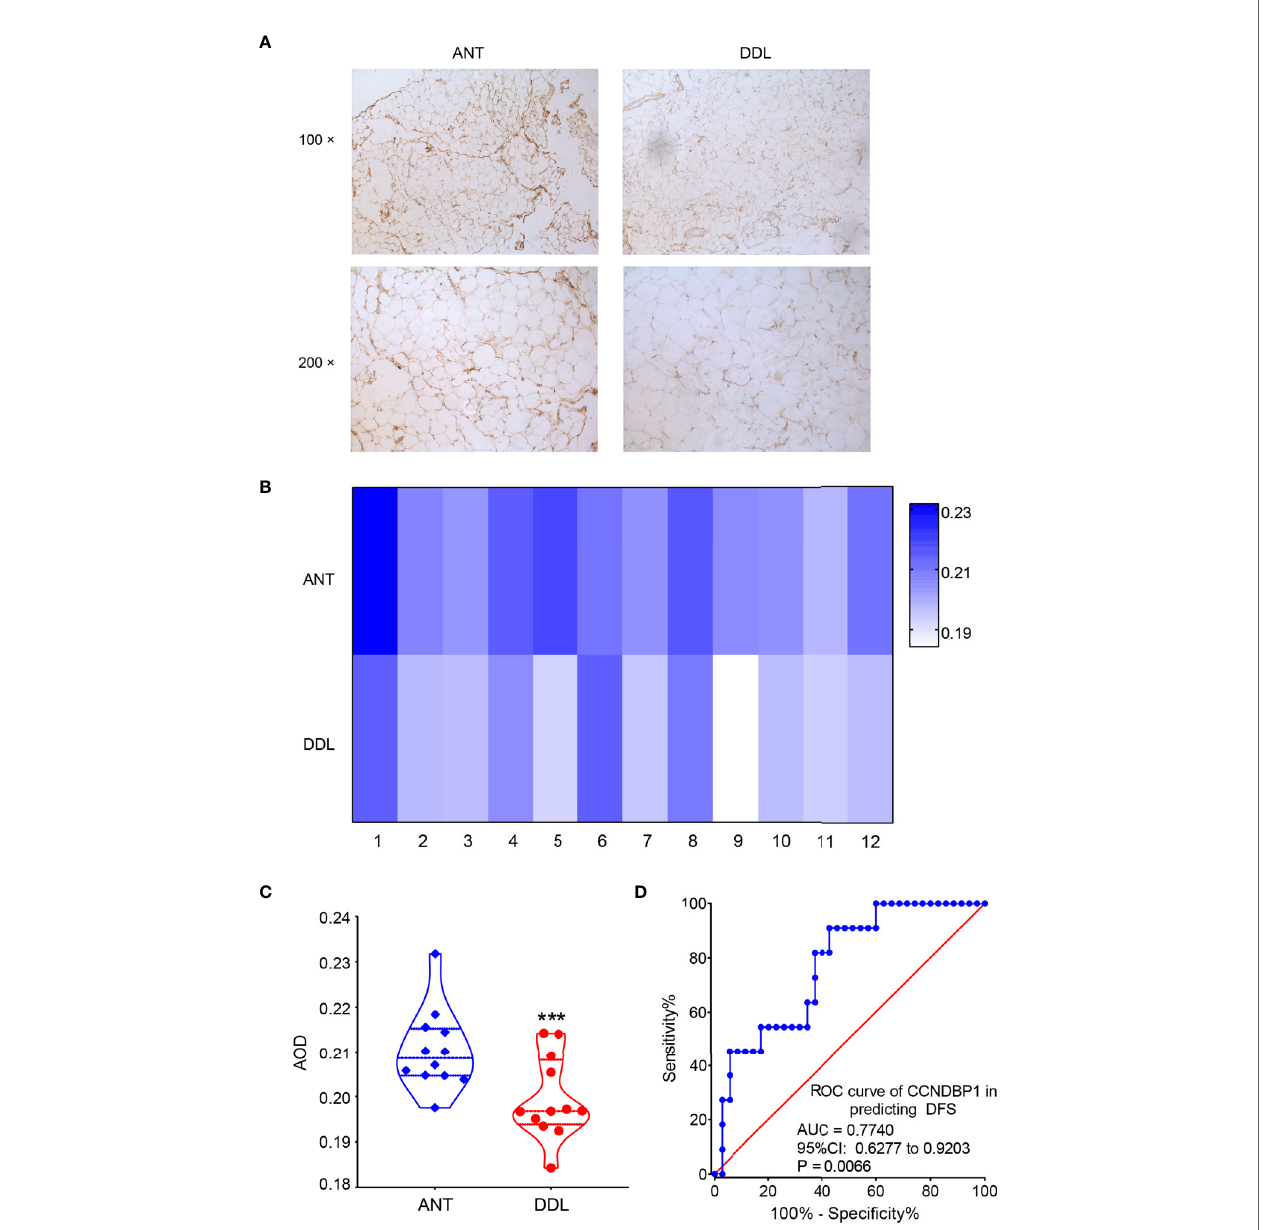
FIGURE 2 | The expression of CCNDBP1 in tissues of DDL was signi fi cantly lower than that in the ANT. (A) The representative images of IHC staining of DDL and its ANT; (B) The heatmap of the AOD value of CCNDBP1 in 12 cases of DDL and the corresponding ANT; (C) The difference of CCNDBP1expression in DDL and their ANT was statistically signi fi cant; (D) ROC curve plotted based on the AOD value of IHC staining of CCNDBP1 and the PFS of the patients. ANT, adjacent normal tissue; ***P <